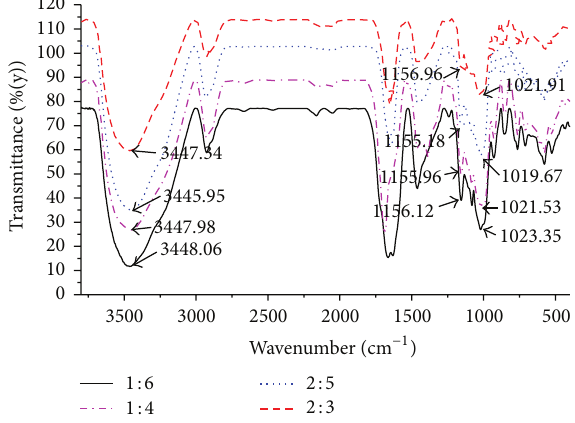
Figure 4: Infrared spectra of different ratios of fiber to